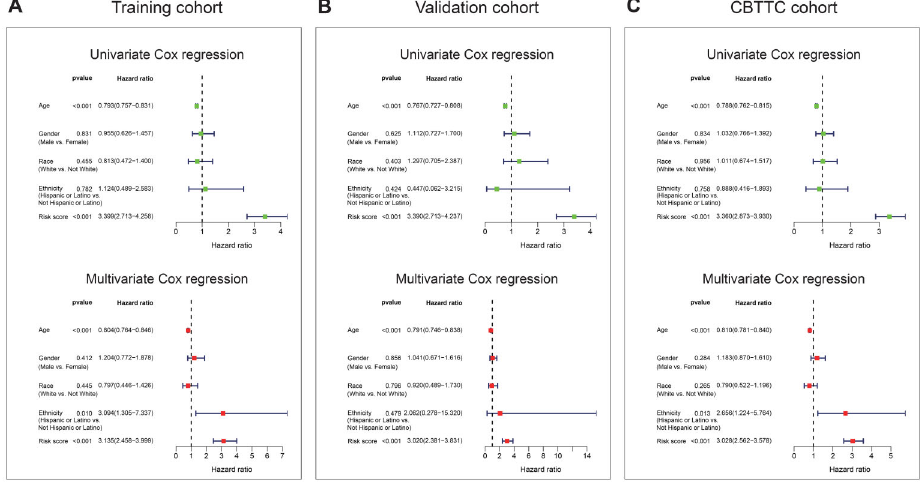
Figure 5 . Forest plot summary of overall survival analyses. Univariate (upper) and multivariate (bottom) analyses based on the eight- gene signature and clinical covariates in training ( A ), validation ( B ), and Pediatric Brain Tumor Atlas (CBTTC) ( C ) cohorts. The colored solid squares represent the hazard ratio (HR), and the transverse lines through HR represent 95% con fi dence intervals (CI). All P values were calculated using Cox hazards regression analysis.